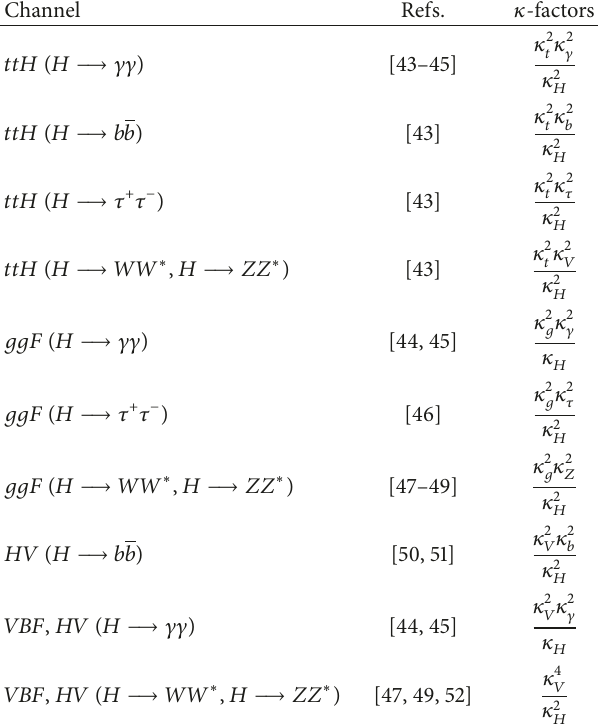
Table 2: List of 13TeV channels considered in the fit, with the corresponding 𝜅 modifiers. Note that the 7 + 8TeV Run 1 data was included using the results of the combination of ATLAS and CMS data in [4].